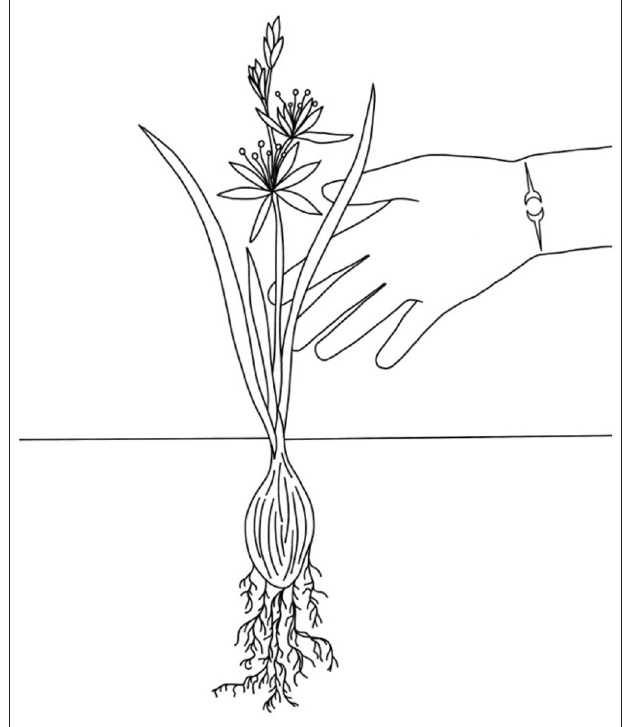
FIGURE 4 | Spánanexw ( Camassia sp.), depicting the below ground bulb that was and is a culturally important food, intensively cultivated in open meadow ecosystems. The bloom above ground is purple-blue in color. (Artist Ocean Hyland from Tsleil waututh and Squamish Nations).